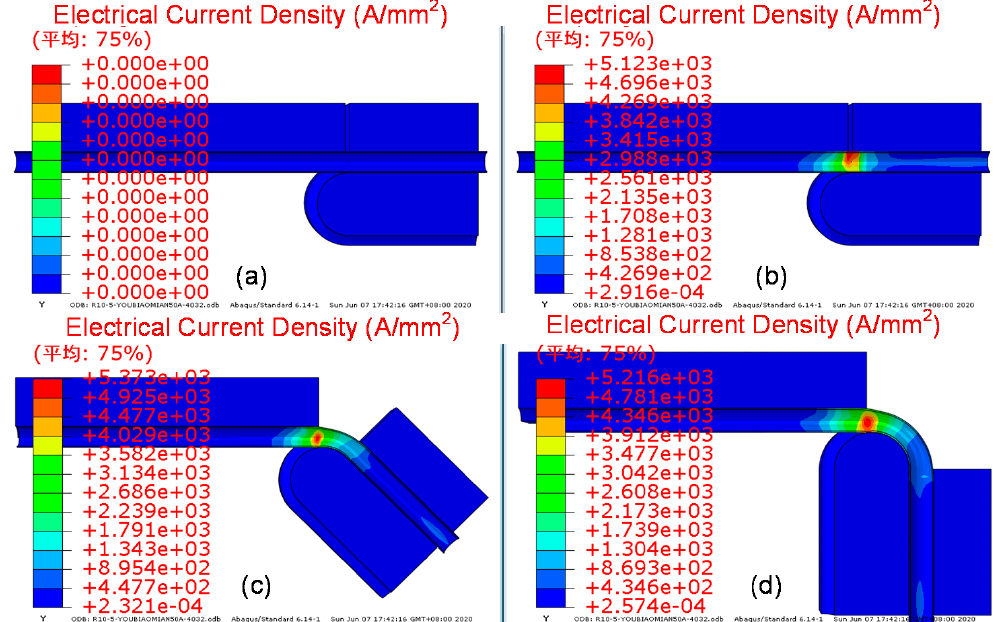
Figure 2. Evolution of current density distribution with time in micro-tube when 50 A/mm 2 passing through the side surface of bend die in EA RDB process: ( a ) 0 s, ( b ) 1 × 10 − 5 s, ( c ) 0.5 s, ( d ) 1 s.